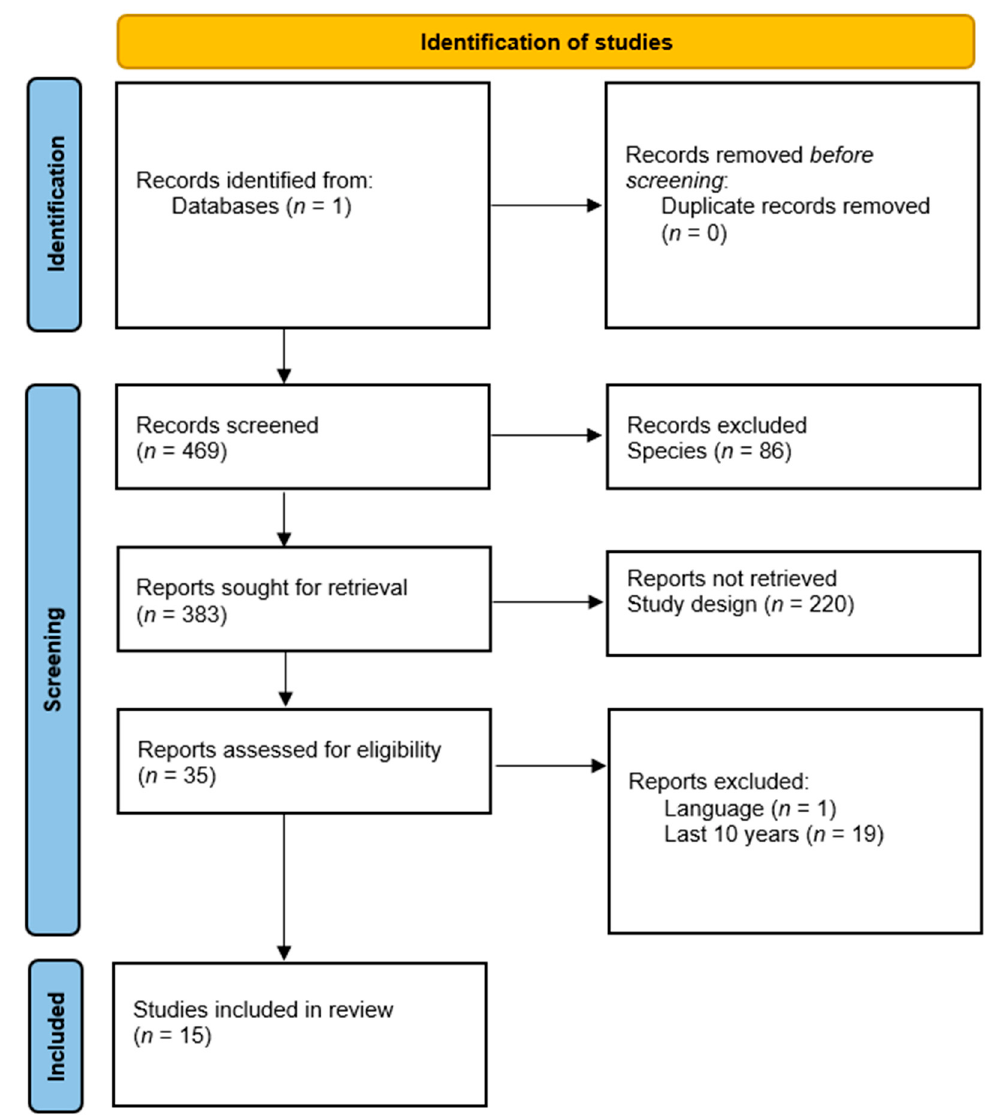
Figure 1. Flow diagram on inclusion